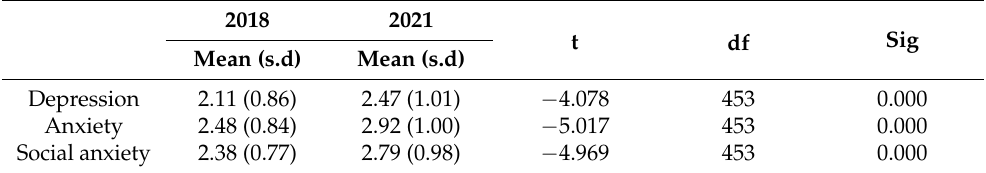
Table 3. Means differences according to the year of evaluation